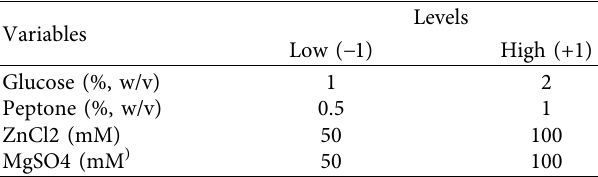
Table 1: Variables and levels used in the 2 4 FFD for the production of bioemulsifier by Stenotrophomonas maltophilia UCP